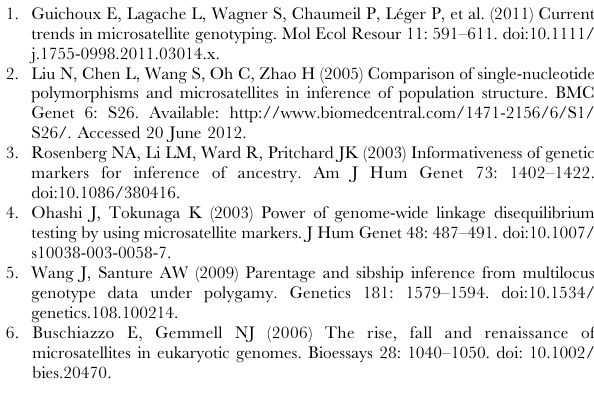
Figure S1 Proportion of microsatellites of each repeat unit length. Coverage of microsatellites of each repeat unit length and homopolymers is divided by the total microsatellite and homopolymer coverage; species follow the same order as in Dataset S1 and in Figures 1 and 2. Figure S2 Correlation between GC% of sequences and A/T rich microsatellite proportions.